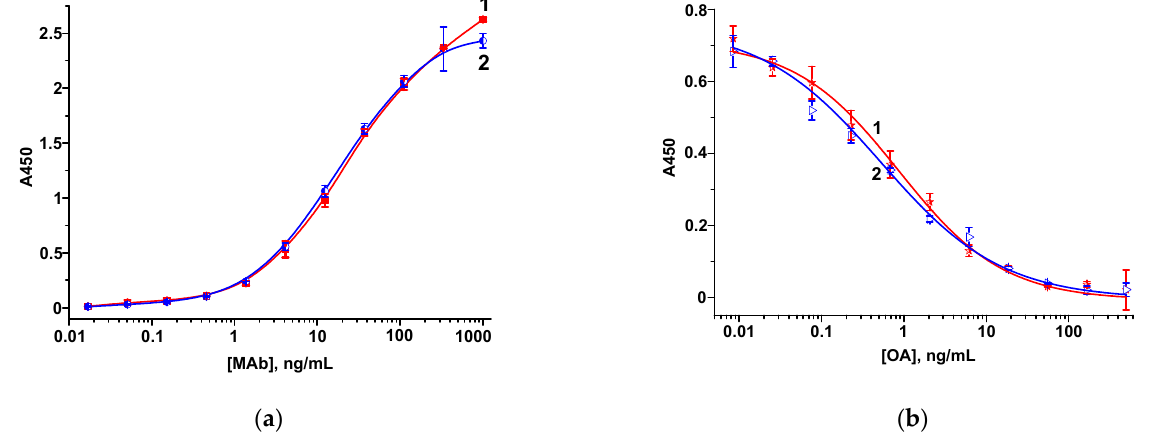
Figure 1. Dependence of A 450 on the concentration of MAbs ( a ) and calibration curves of OA ( b ) in the ELISA with immobilized OA–BSA (1) and OA–STI (2) ( n = 3).